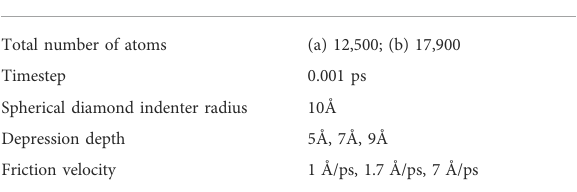
TABLE 1 Parameters of MD